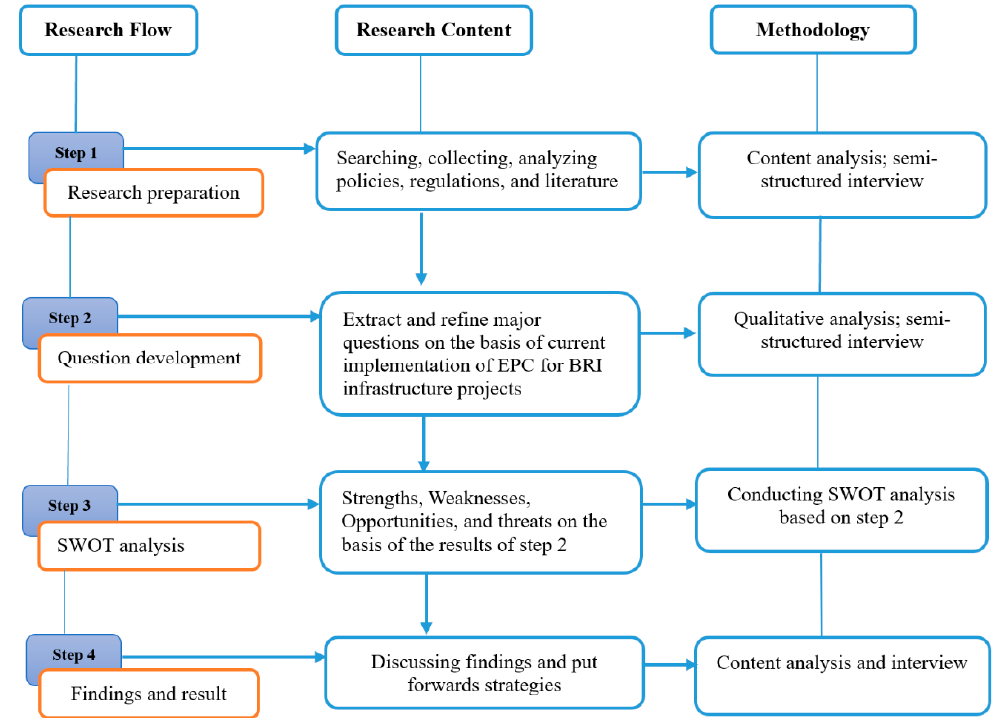
Figure 1. A methodological framework of the study.